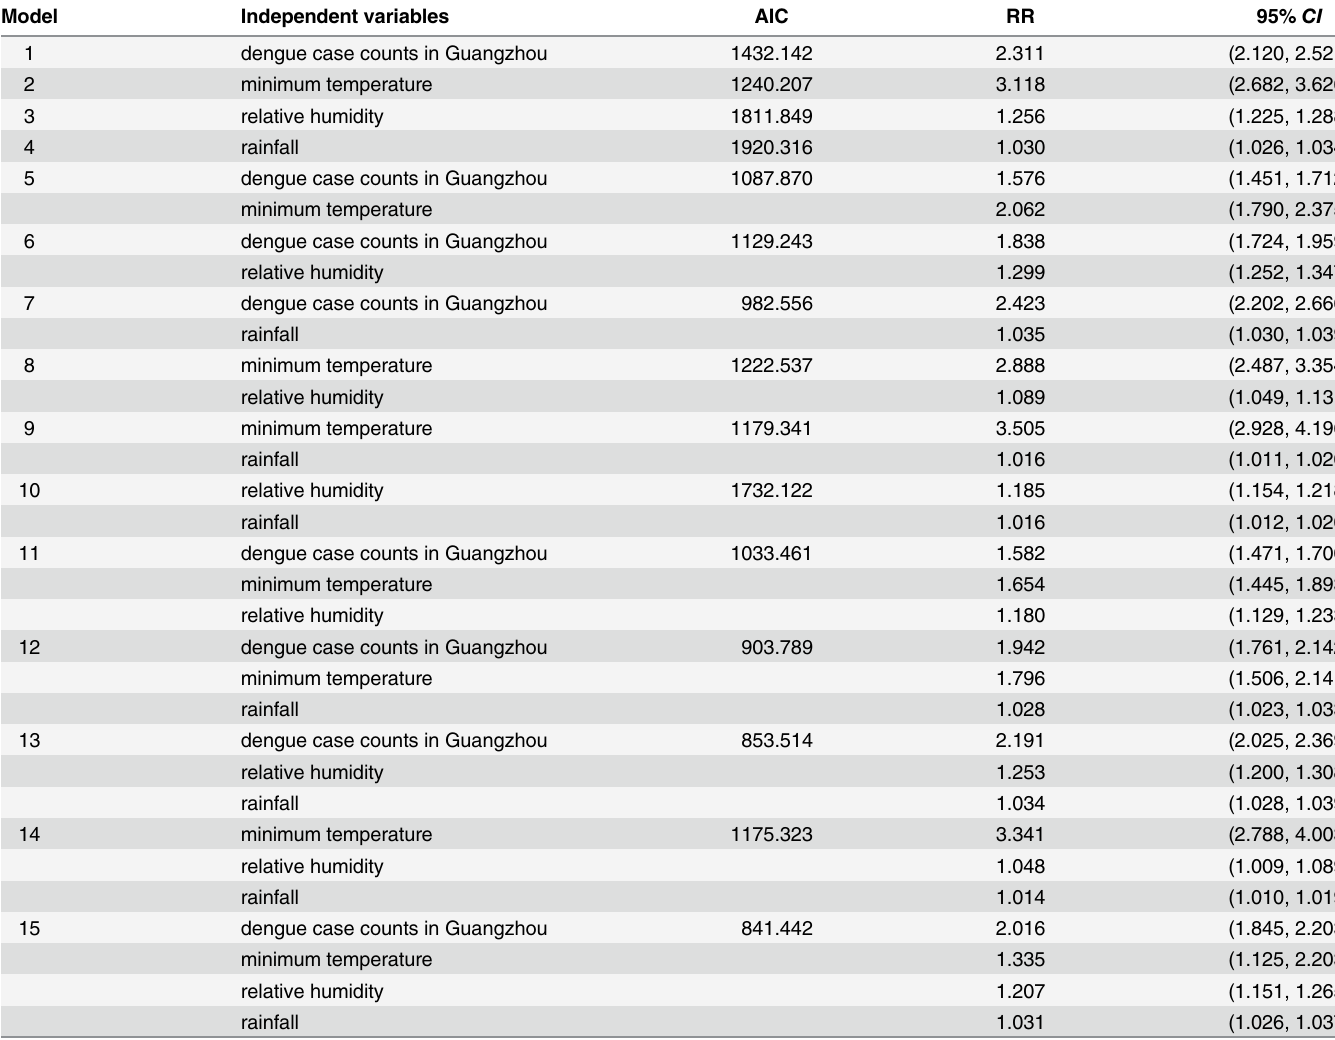
Table 1. Regression models with different combination of the four candidate independent